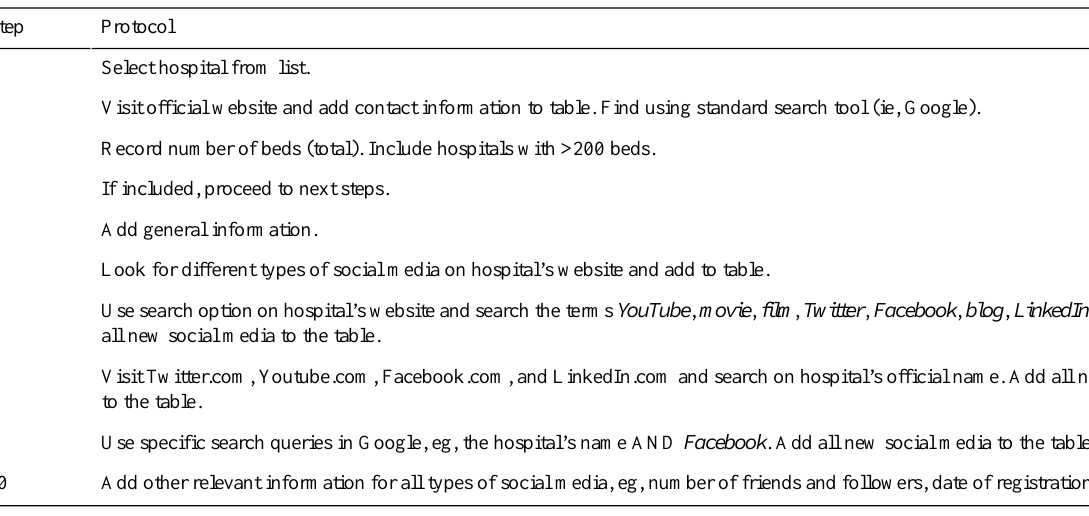
Table 1. Search protocol for data collection.